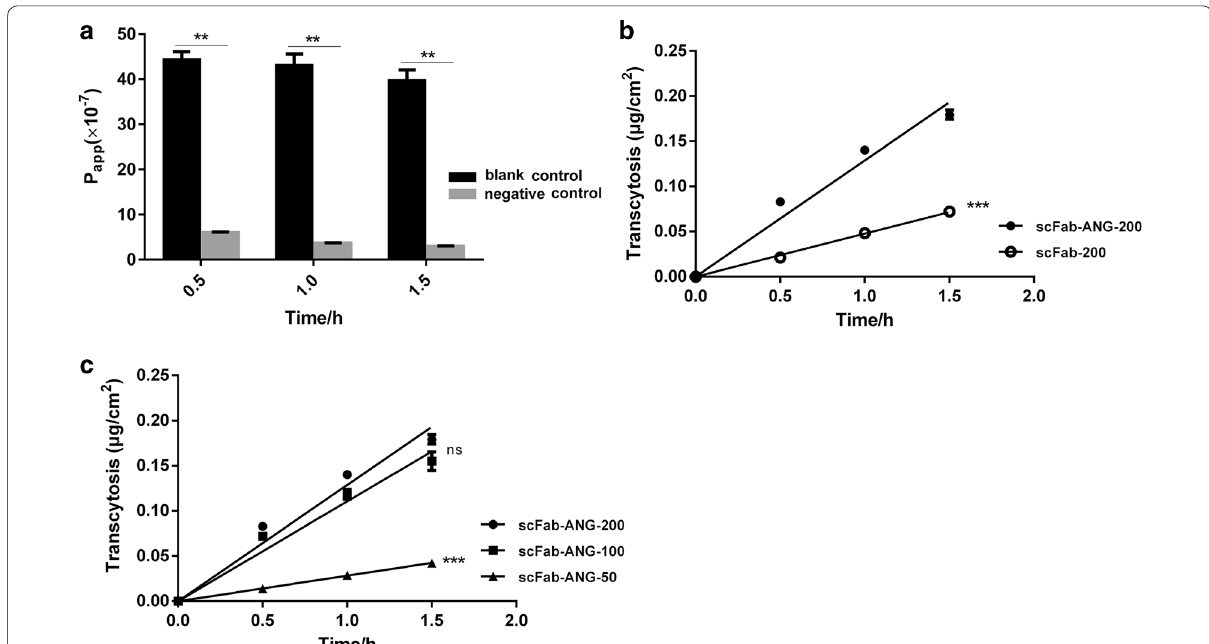
Fig. 3 Transport across in vitro BBB model. a P app of FITC-dextran (500 μg) across polycarbonate membrane in negative group (with hCMEC/D3 cell monolayer) or blank control group (without cell monolayer). b Transcytosis curve of scFab-ANG and scFab with 200 μg. c Transcytosis curve of scFab-ANG (200 μg, 100 μg, 50 μg)